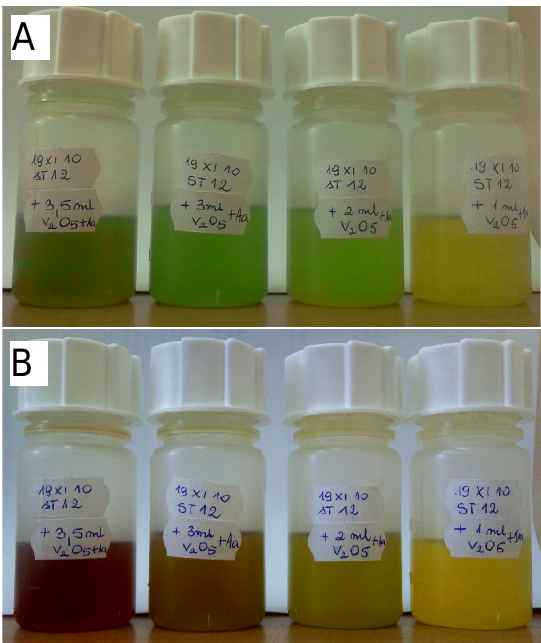
Fig.2. Colour of the sols: A-after preparation, B-two weeks later Figure 1. Sol preparation procedure